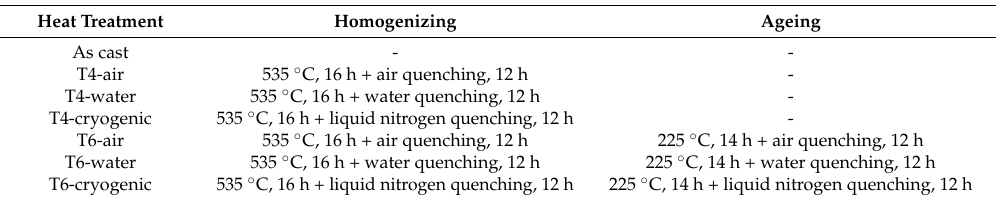
Table 1. The heat treatment process of Mg-7Y-1.5Nd alloy in this study. Heat